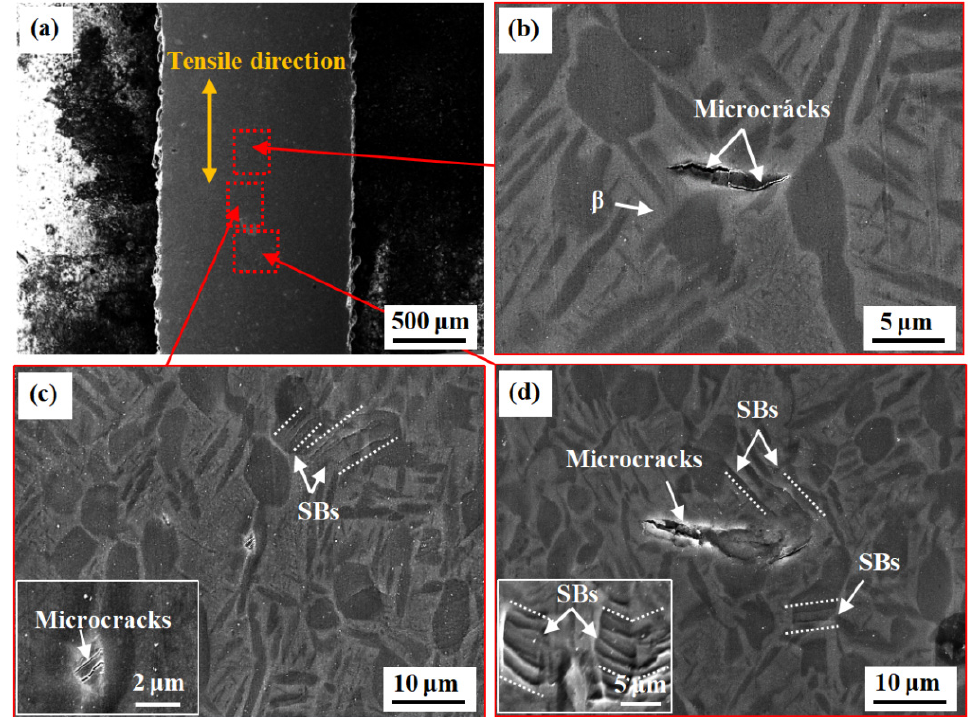
Figure 5. ( a ) In situ SEM images of bimodal microstructure at A (the displacement of 467 µ m); ( b ) microcracks nucleated at α phase; ( c ) microcracks and SBs formed within the α P phase; ( d ) magnified image showing SBs passing through the interface between the α P and β phases.